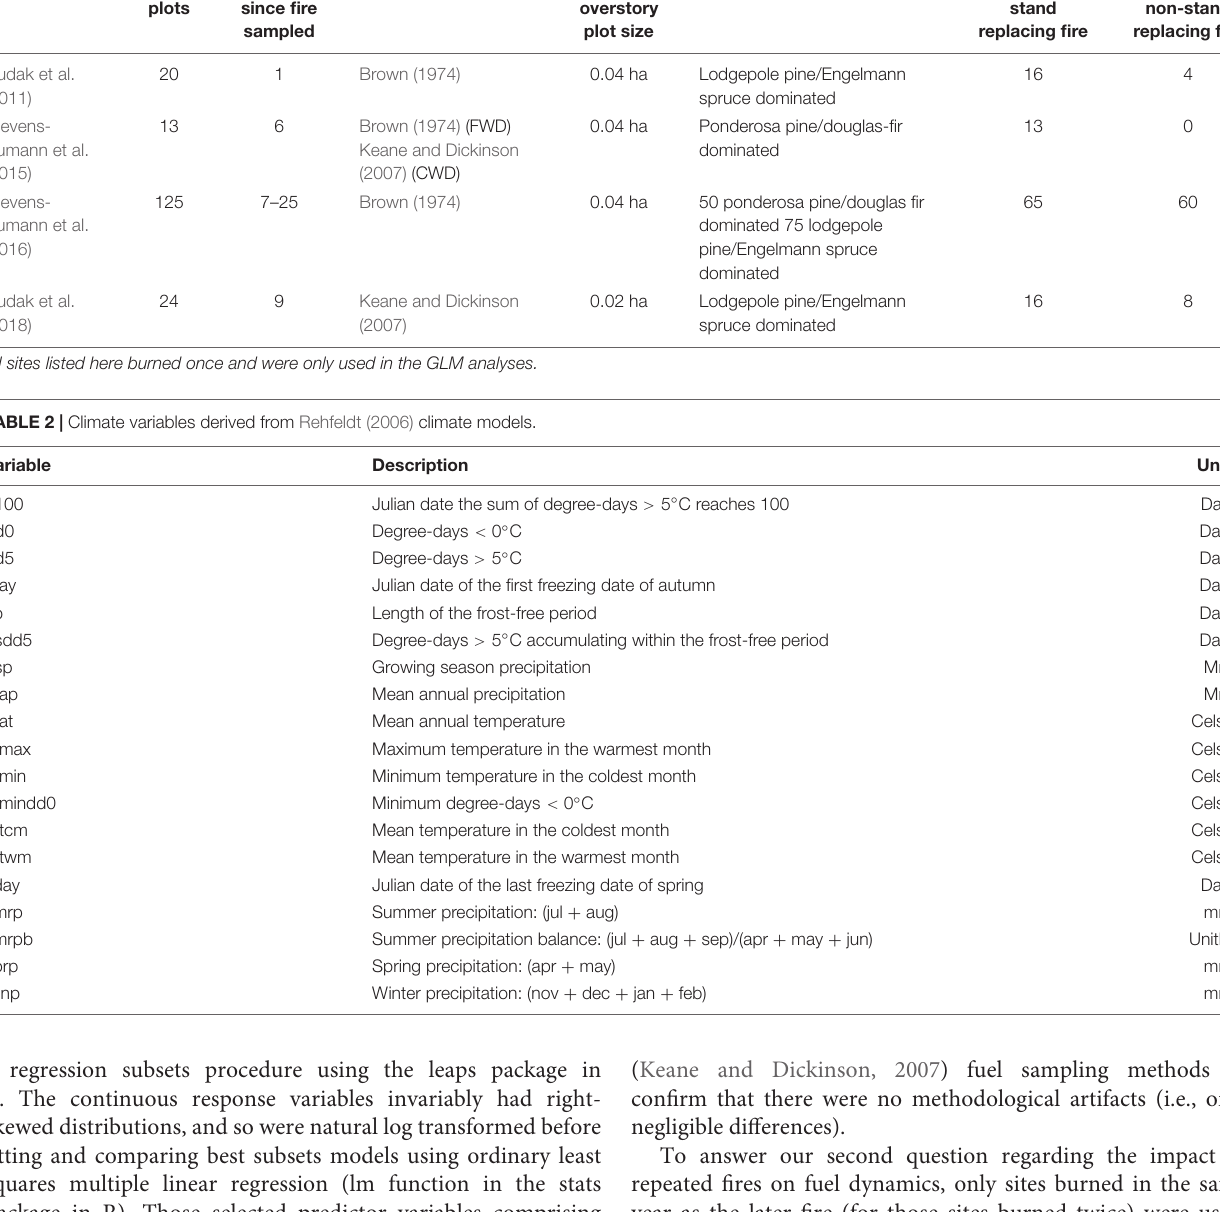
TABLE 1 | List of studies, with number of sites and surface fuel methods described. Study